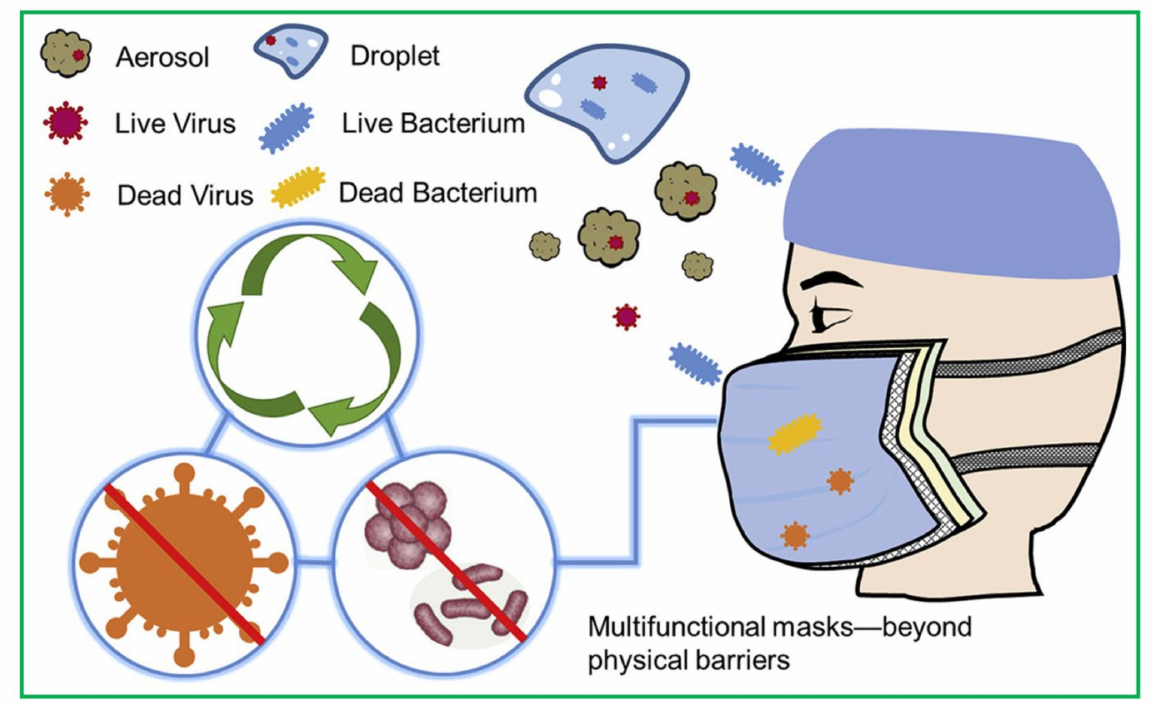
Figure 5. Significance of SARS-CoV-2-virus-containing droplet interfacial interaction with a soft superhydrophobic material such as a face mask